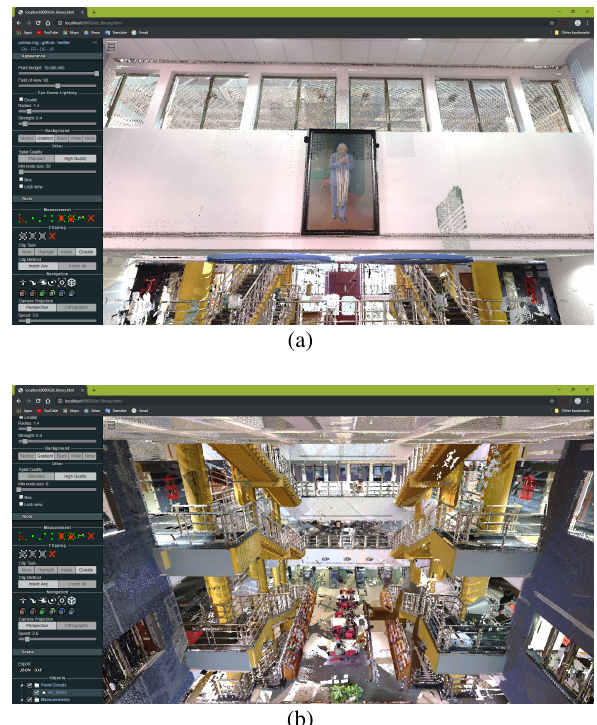
Figure 4. Visualisation of the interior of the library using Potree renderer.